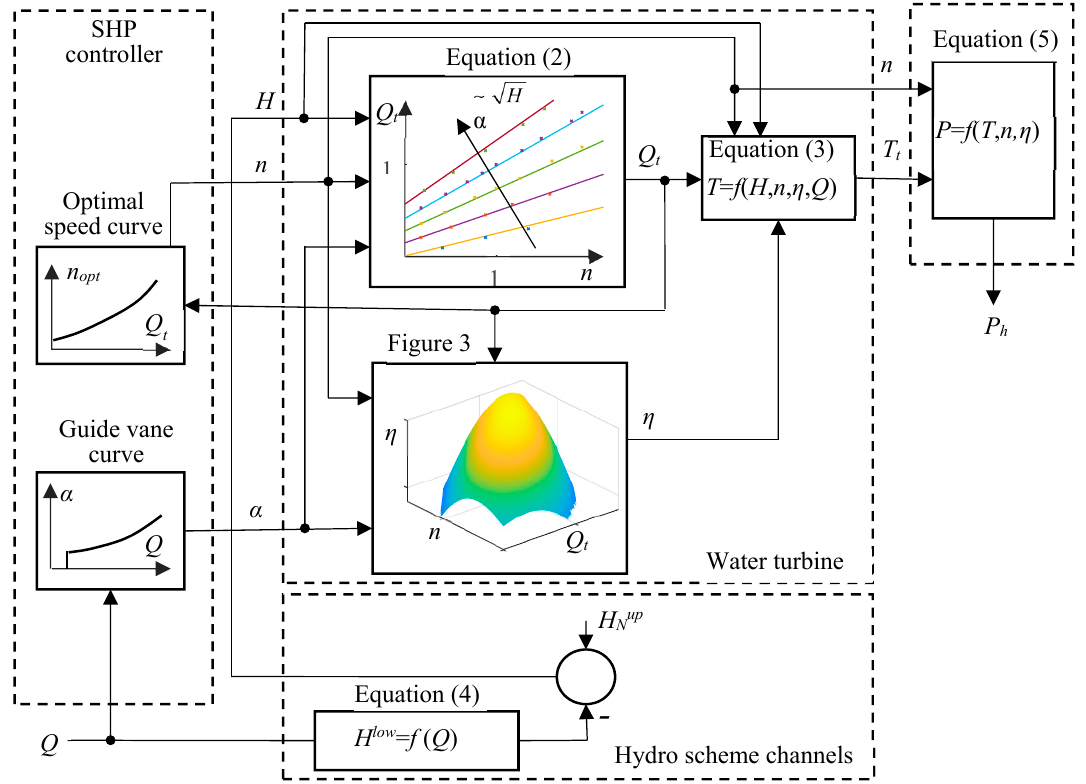
Figure 5. Schematic of the run-of-the-river hydropower plant model.